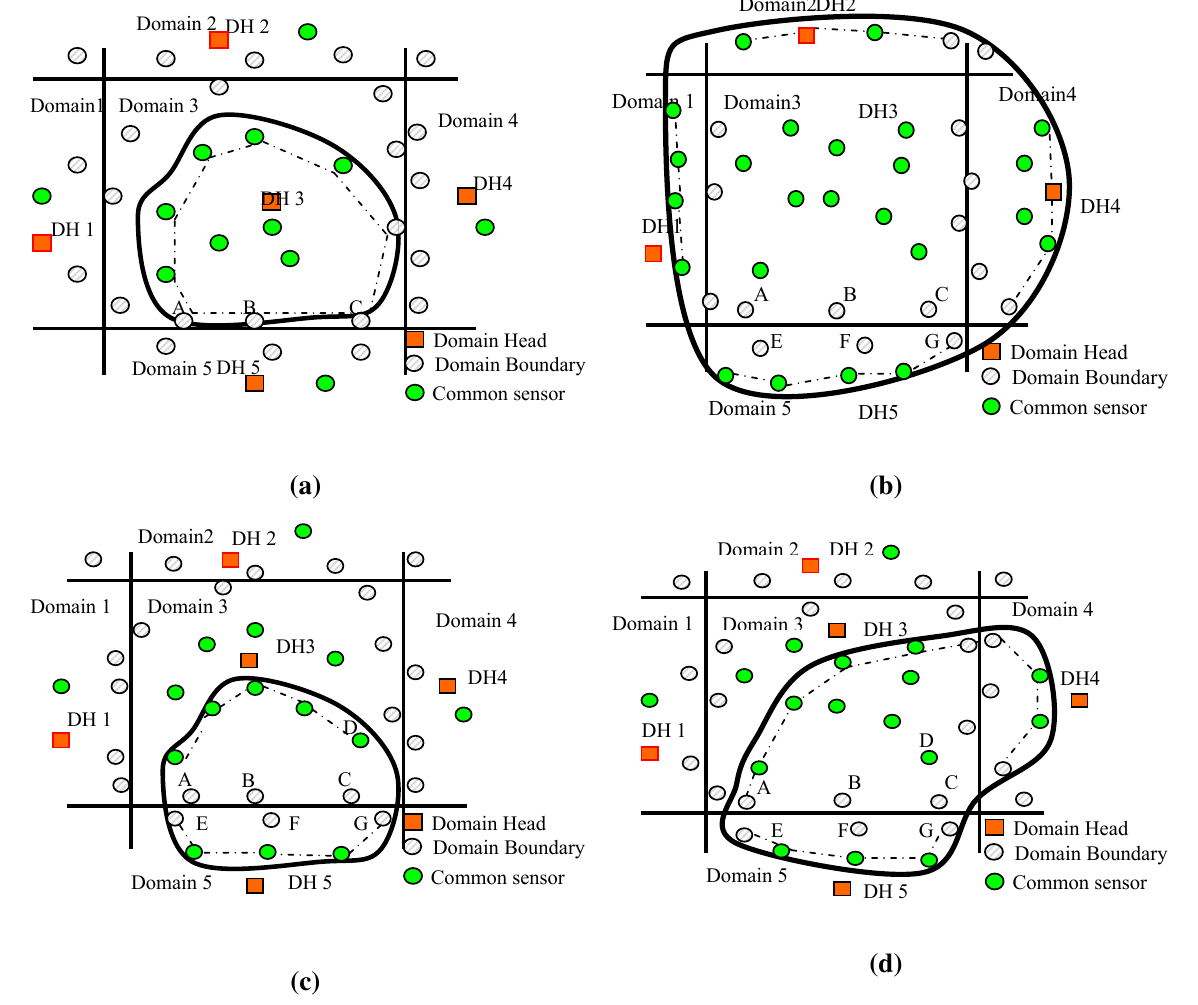
Fig.5 Boundary detecting and tracking of heritage: (a)heritage shape lies within a single domain;(b) heritage shape fully covers a domain;(c) heritage shape spread across two domains;(d) heritage shape spread across three domains.